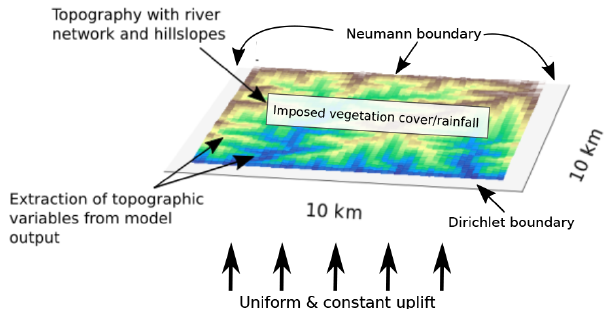
Figure 3. An example of the model setup used in the simulations in this study, showing model predicted topography with a set drainage network, draining to the south. Boundary conditions and parameter- izations used in the models are labeled. Blue represents low eleva- tions and brown represents higher elevations. Additional details of parameters used are specified in Table